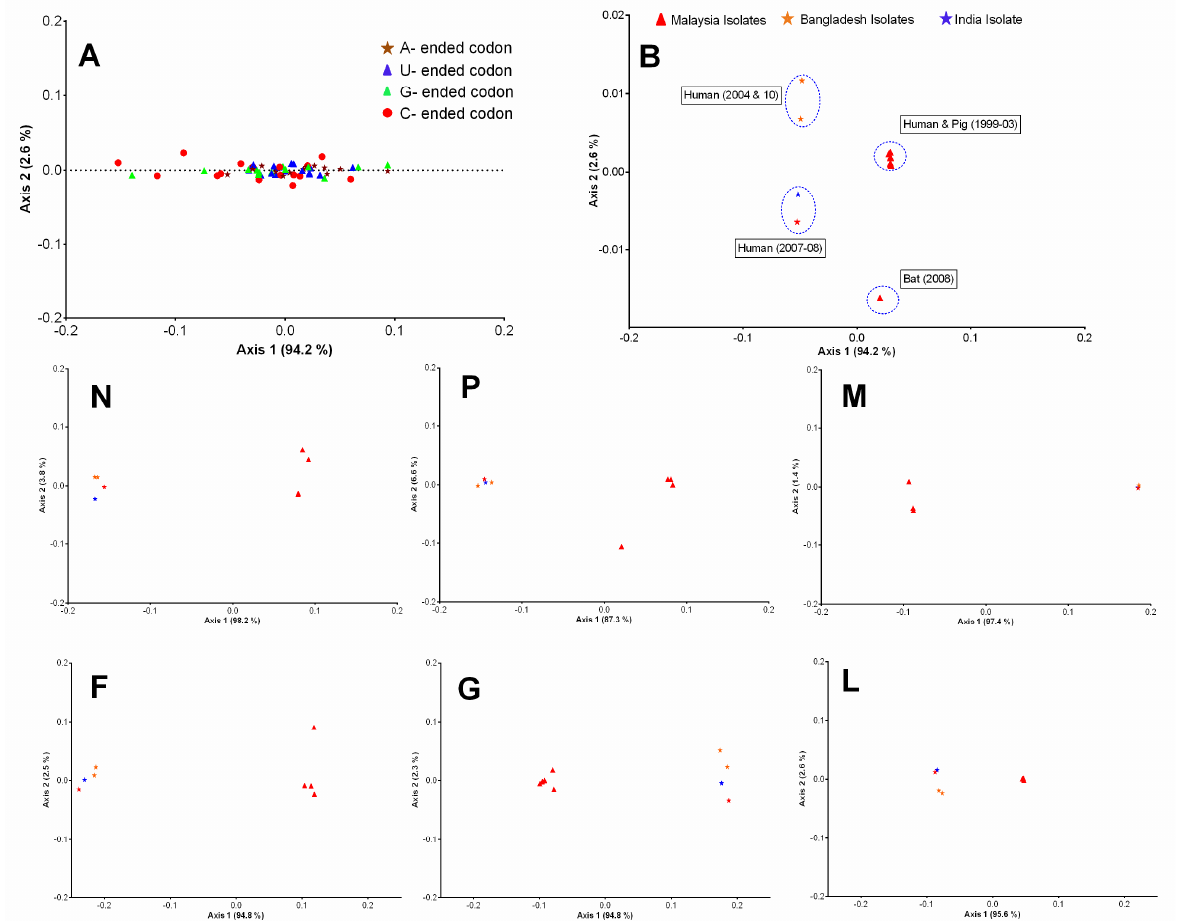
Figure 2. Codon usage variations in the coding sequences of NiV. Correspondence analysis (COA) was performed on the RSCU of codons ( A ) and complete coding sequences of NiV isolates ( B ) and plotted on the first two-main-axes. The COA analysis of individual protein-coding sequences (N, P, M, F, G, L) of NiV was also plotted on the first two-main-axes. The different base-ended codons and geographically distinct NiV isolates were color labeled.